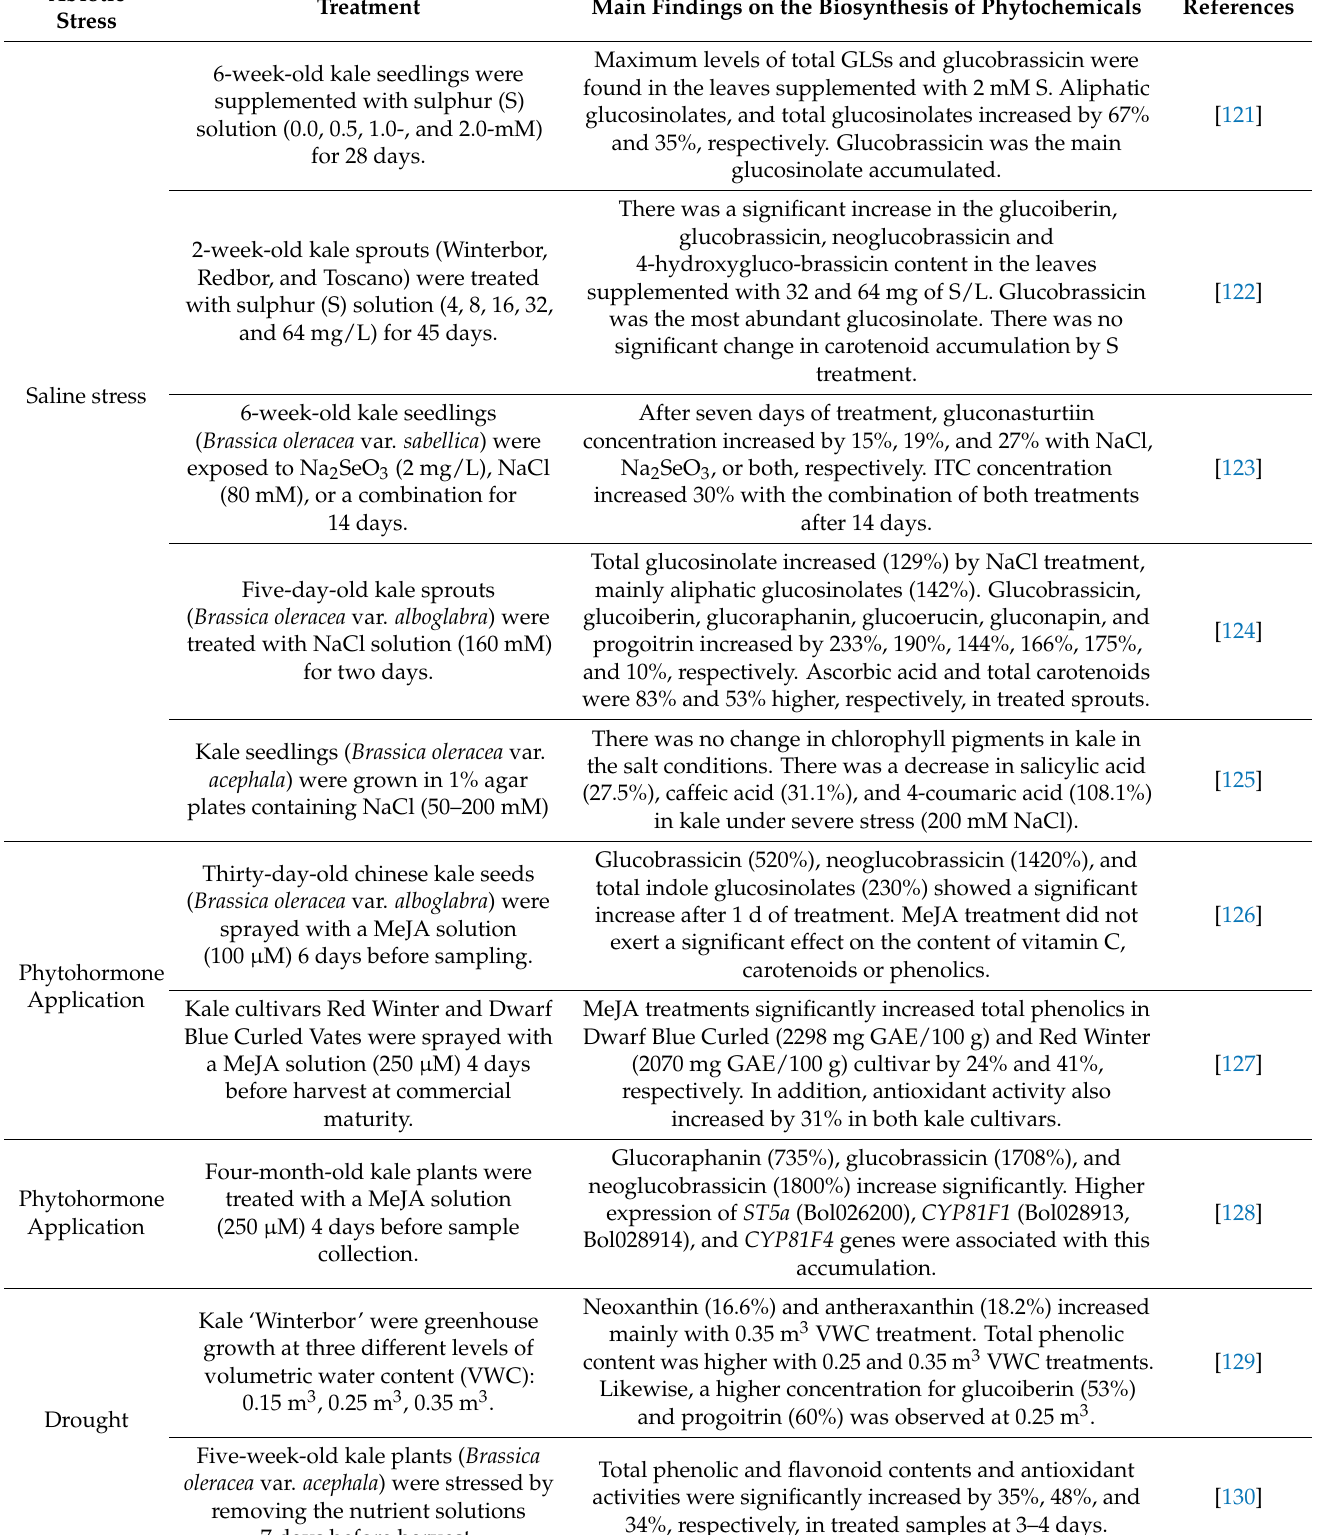
Table 5. Effect of different abiotic stress conditions on the accumulation of health-promoting compounds in kale. Abiotic